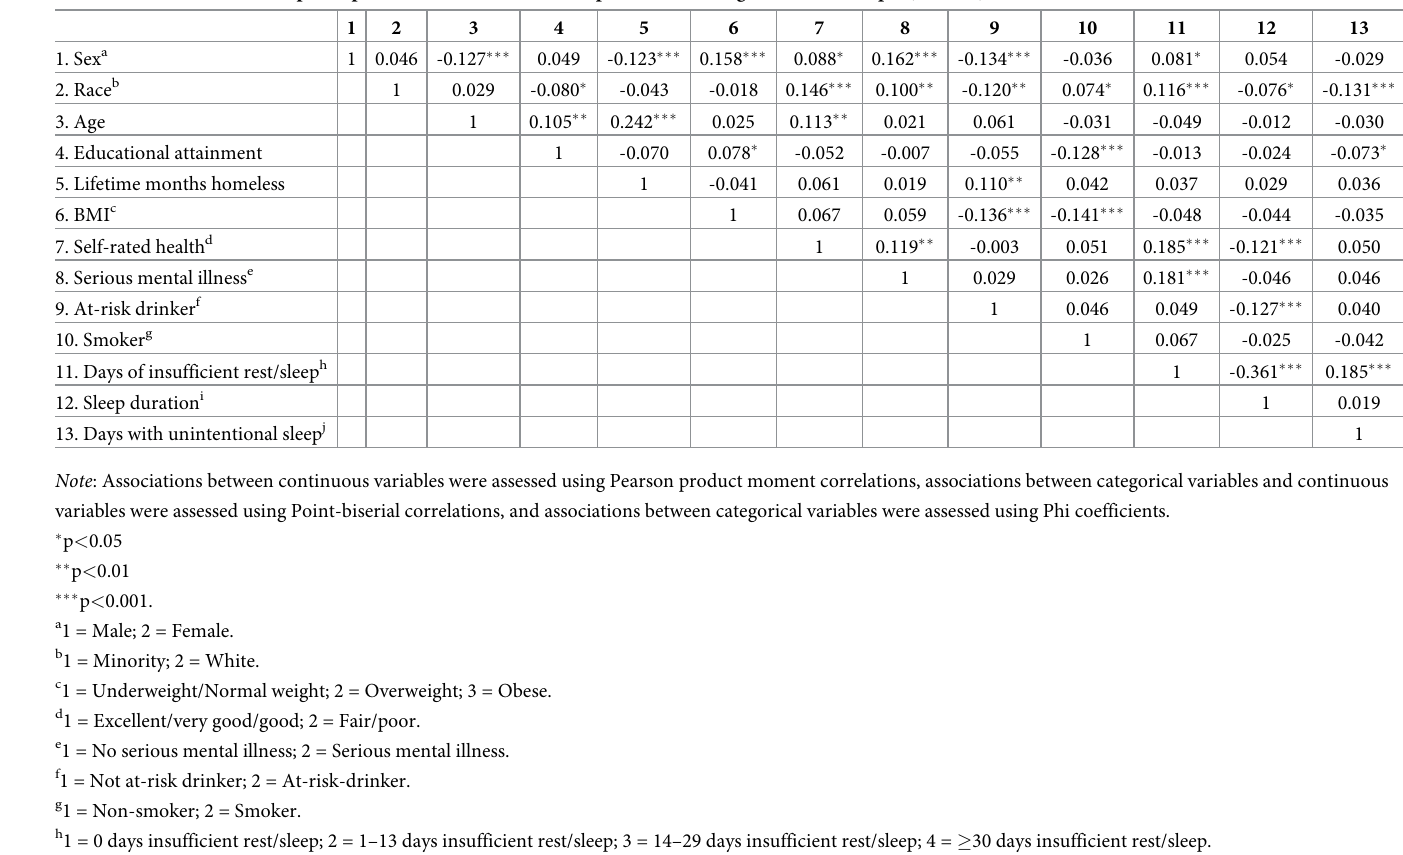
Table 2. Intercorrelations of participants’ characteristics and sleep variables among a homeless sample (N =